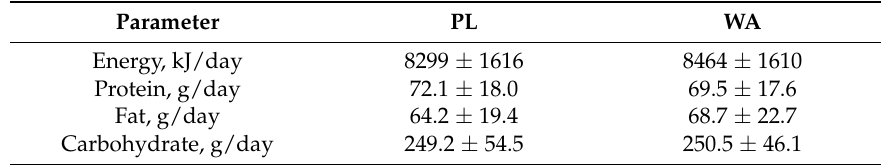
Table 2. Dietary records of the three days before the treatment.